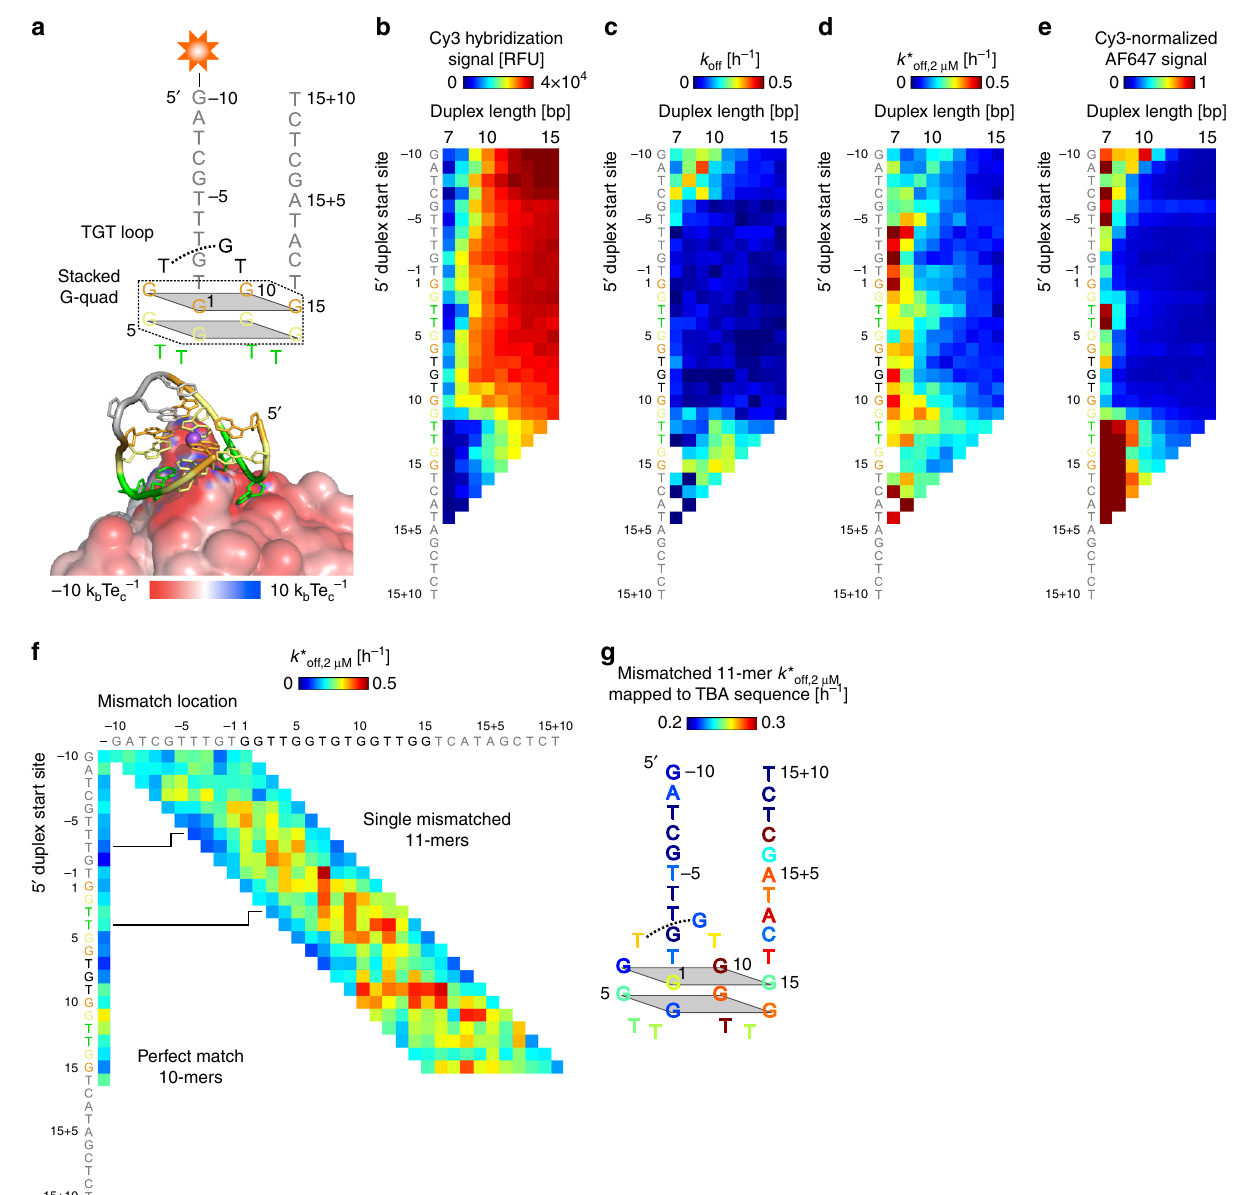
Fig. 5 Two-color ACE-Scan of TBA DAs. a Upper, secondary structure of the TBA construct used here, with 5 ʹ and 3 ʹ extensions colored in gray, TT loops colored in green, and proximal and distal G-quadruplex tetrads colored in yellow and orange, respectively. Lower, 3D view of the interaction of native TBA with human alpha thrombin exosite I (PDB 4DIH 37 ). Colored surface shows the APBS-predicted electrostatic potential molecular surface of thrombin, purple sphere represents a sodium ion. b – d ACE-Scan generated ( b ) DA hybridization af fi nity landscape, ( c ) buffer-only k off landscape, and ( d ) thrombin- induced k * off,2 µ M landscape. e Heat map of the Cy3-normalized signal of AF647-labeled thrombin molecules bound to surface-based TBA DAs after incubation with 2 µ M thrombin for 1 h. f k * off,2 µ M landscape for DAs engineered with single mismatched 11-mer ACEs. Left-hand column represents perfect match 10-mer ACEs. g Linear mapping of the mismatched 11-mer ACE induced fi t landscape onto the TBA sequence (Methods